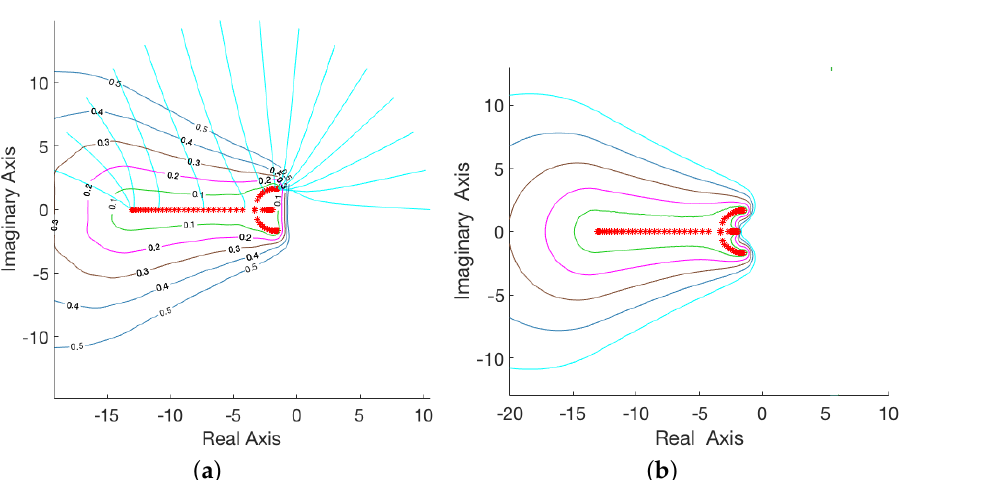
Figure 5. Pseudospectrum computation for a damped mass-spring system. ( a ) Approximate pseu- dospectra visualization, interpolating along 15 trajectories of converging sequences. ( b ) Pseudospec- tra visualization, using the modified grid algorithm in